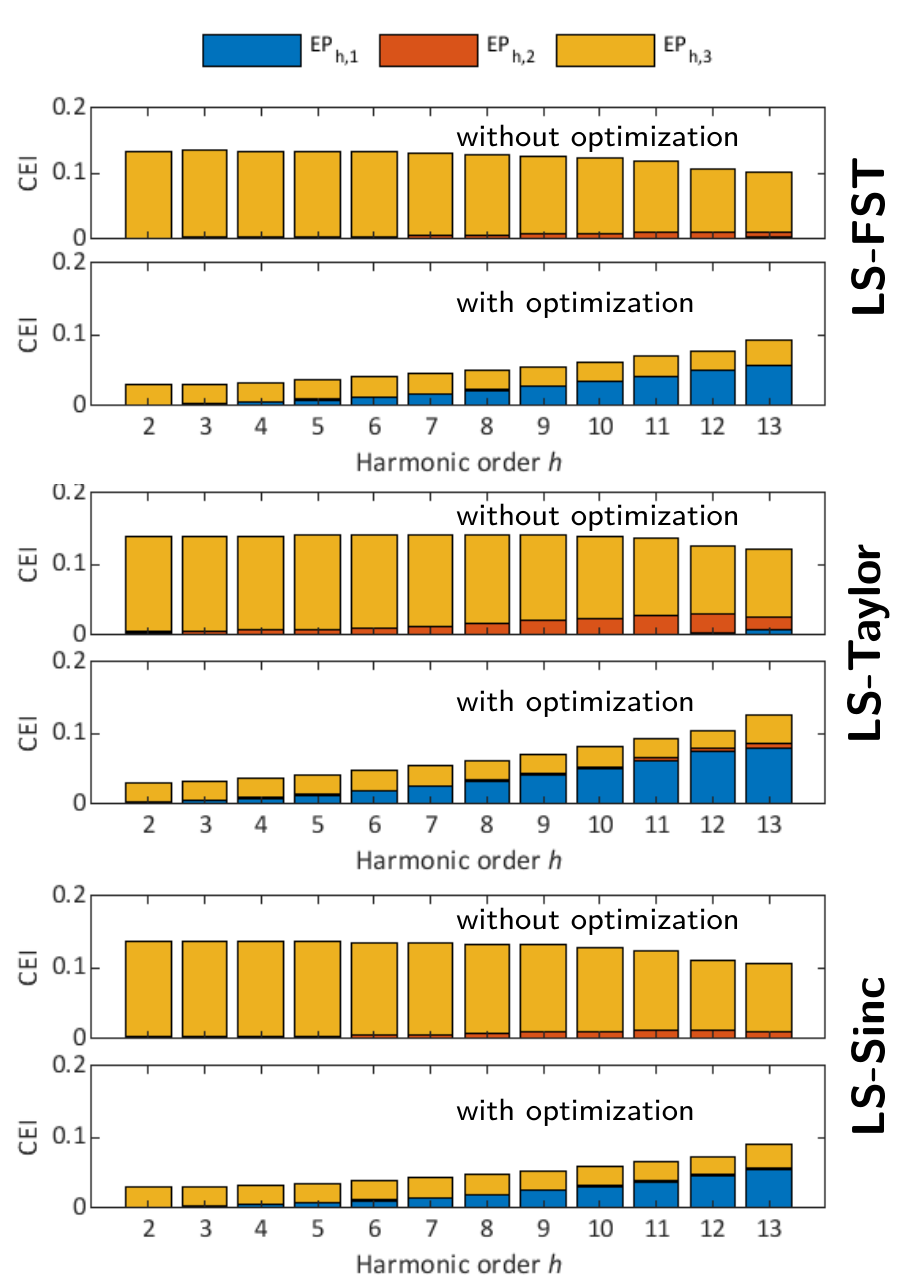
Figure 2. The CEI distribution of three least-square algorithms with and without using the pro- posed optimization.